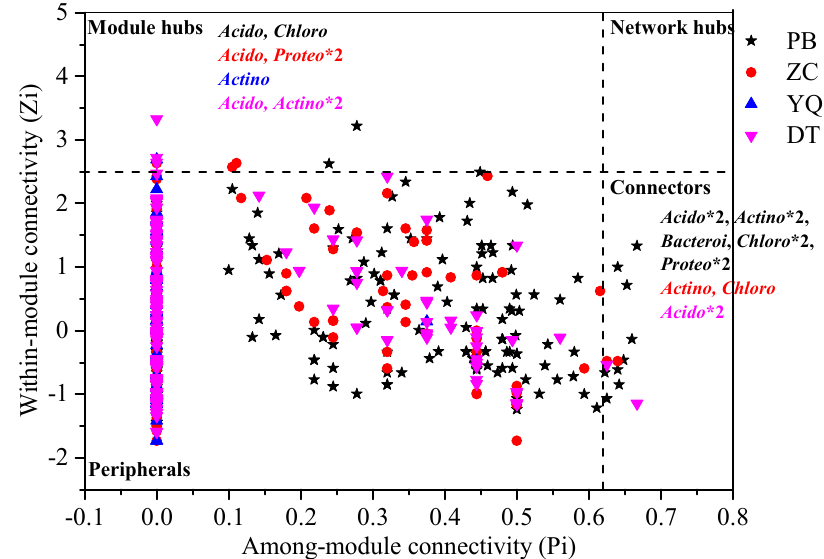
Figure 5. Z–P plot showing the keystone species in the different mining area networks. Different symbols with special colors represent di ff erent networks as follows: black star for the PB network, red circle for the ZC network, blue upward-facing triangles for the YQ network, and rose downward-facing triangles for the DT network. The module hubs and connectors are labeled with phylogenetic affiliations ( Acido—Acidobacteria, Actino—Actinobacteria, Bacteroi—Bacteroidetes, Chloro—Chloroflexi, and Proteo—Proteobacteria . *2 means that there are 2 connectors or 2 module hubs belong to that phylum).